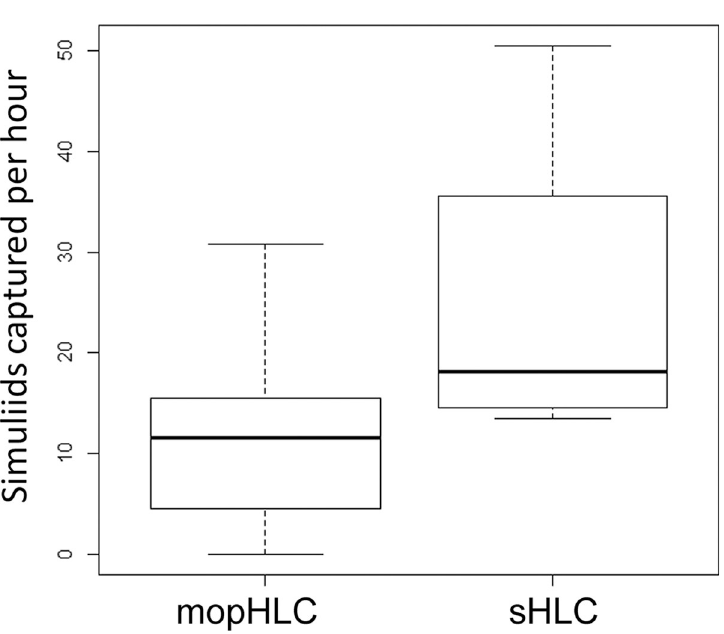
Fig 5. Shows a capture efficiency comparison between sHLCs and mopHLCs performed in isolation of sHLCs. These box plots were prepared from simuliid capture data collected from the eight mopHLCs and four sHLCs performed between the 27th and 28th of October 2017. The Y-axis of the graph indicates the efficiency with which each technique traps simuliids in units of “simuliids captured per